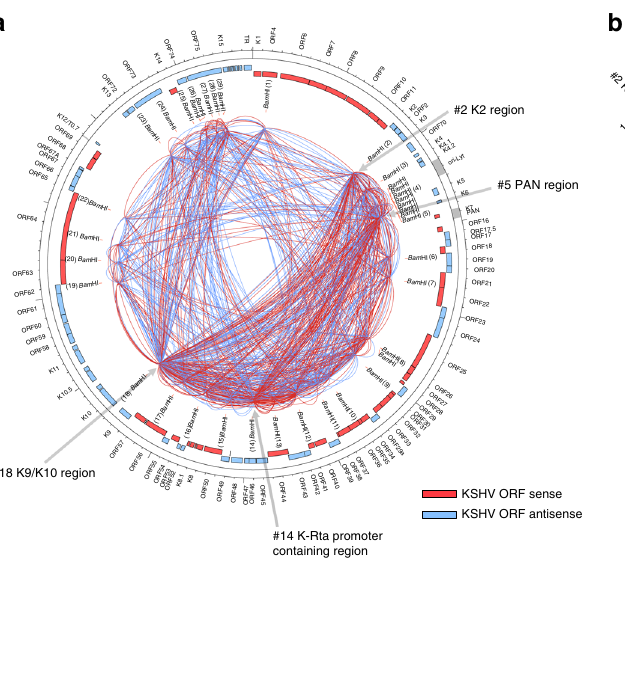
genomic binding site/looping effect, per se. To address this, PAN vector 48 h prior to dox-induced reactivation. This raised the level